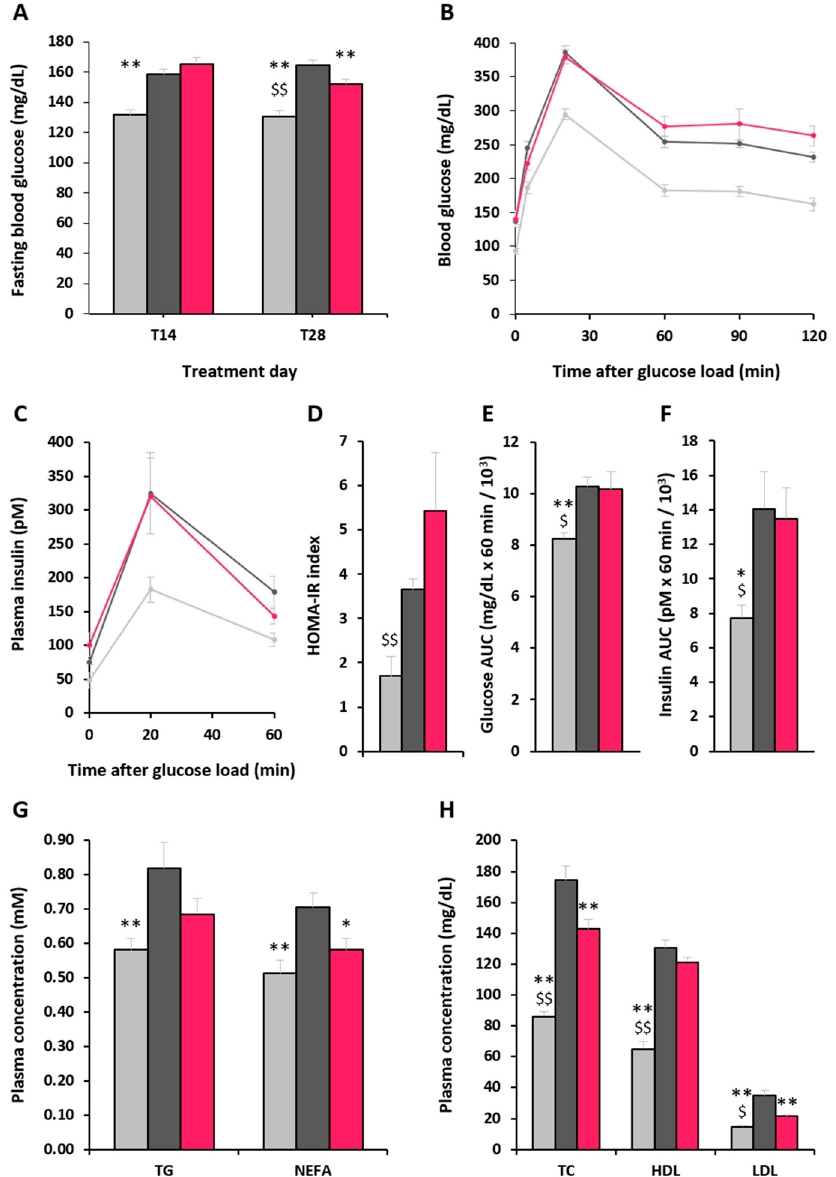
Figure 2. Effect of α -GOS on plasma parameters during the treatment phase. ( A ) Fasting glycaemia. ( B ) Glycemia kinetics after test meal ( C ) Insulinemia kinetics after test meal (D) HOMA-IR ( E ) Glycemia AUC after test meal ( F ) Insulinemia AUC after test meal ( G ) Triglycerides and non-esterified fatty acids. ( H ) Total cholesterol, HDL and LDL. Data are mean ± standard error of the mean (SEM). NC, light gray bars, n = 8 except for FG n = 16; HFD-control, dark grey bars, n = 10 except for FG n = 20; HFD- α -GOS, pink bars, n = 10 except for FG n = 20. * p < 0.05 and ** p < 0.001 vs. HFD-control group; $ p < 0.05 and $$ p < 0.001 for NC vs. HFD- α -GOS. Treatment days (T) refer to the numbers of days after initiation of treatment with either the vehicle (NC and HFD-control groups) or α -GOS (HFD- α -GOS